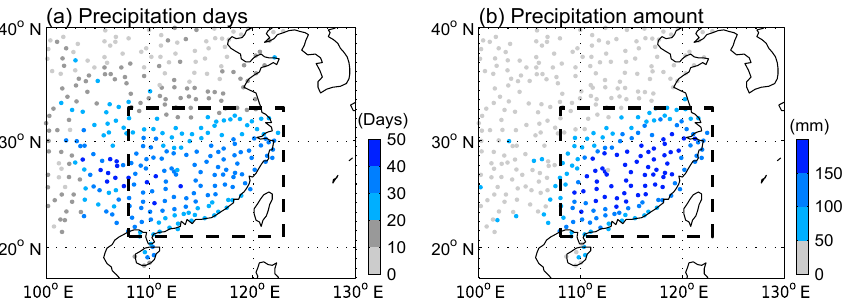
Figure 1. Spatial distribution of January–February precipitation days (a) and precipitation amount (b) for the period of 1979–2012. The study area is shown in a black dashed rectangle.